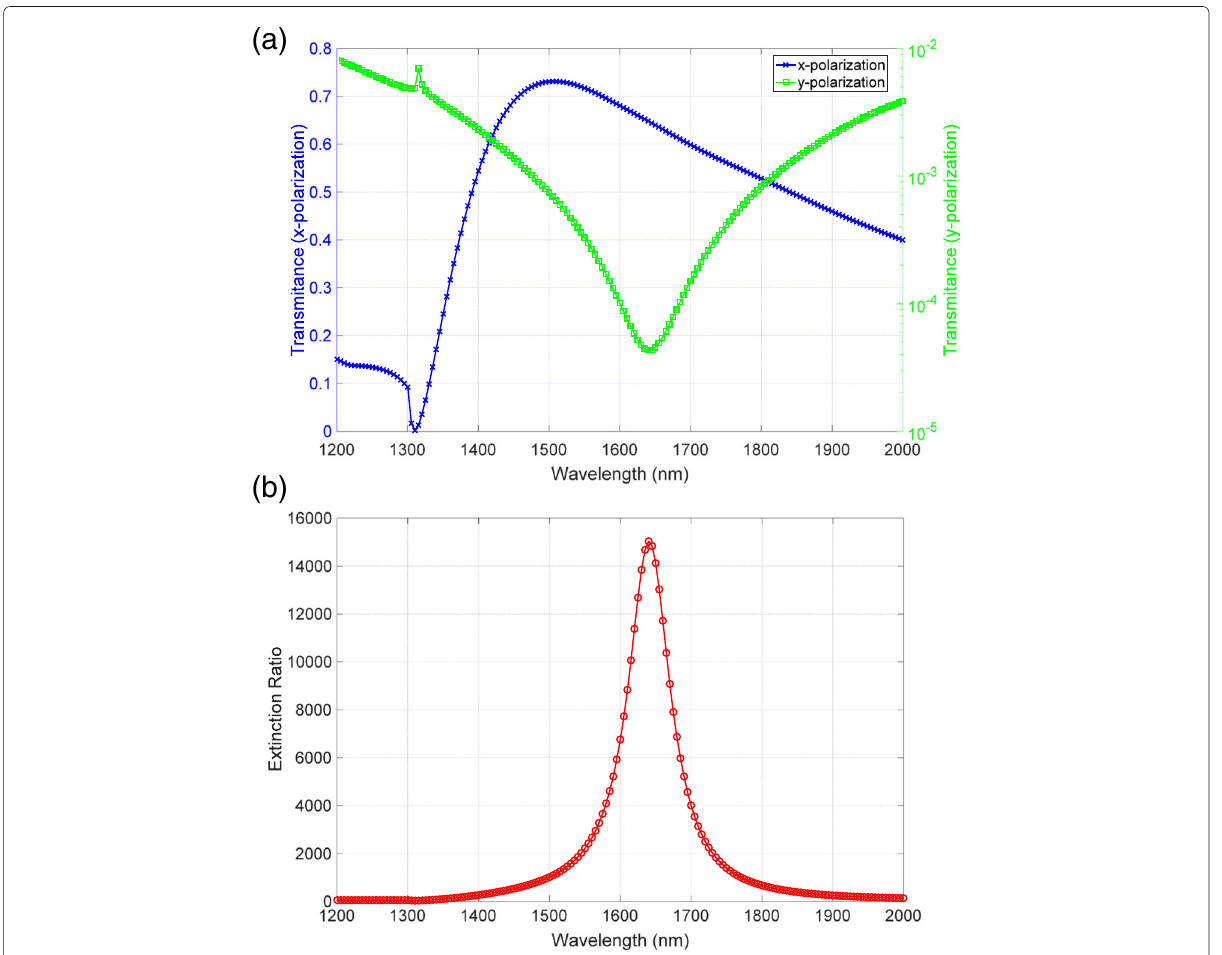
Fig. 6 Numerical calculation results of a transmittance and b extinction ratio spectra. The blue and green lines in a correspond to the x and y polarizations, respectively